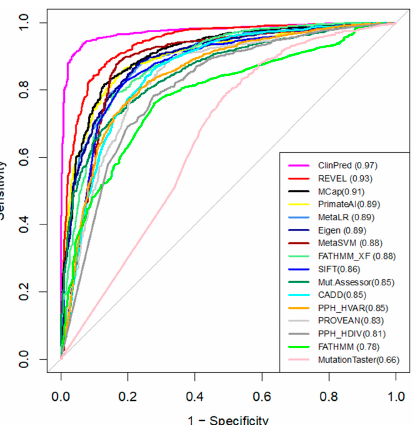
Figure 2. The ROC curves of the 16 tools tested on the broad dataset. The higher AUC score (shown in brackets), the better the performance. 3.6. Reclassifying VUS Variants of hCav1.2 with ClinPred and Paralogue Annotation Most of the Cav1.2 variants in our broad dataset are currently classified as VUS. We used the best ‐ performing tool, ClinPred, to predict the pathogenicity of VUS’. ClinPred predicted 188 VUS variants as pathogenic/likely pathogenic (pathogenicity threshold > 0.66). Among the 188 VUS, we further selected only those variants that are annotated as pathogenic or likely pathogenic in at least one of 20 paralogs of Cav1.2 (conservation score across paralogues Cs > 0.3). Both methods consensually predicted 36 of 309 VUS as P/LP variants. We reclassified these as putative P/LP variants (Table 4). The variants were lo ‐ calized mainly in the extracellular loops DI ‐ S5/S6 and DIII ‐ S5/S6 (Figure 1). Table 4. hCav1.2 variants whose status was changed from “uncertain significance” to “patho ‐ genic/likely pathogenic”.